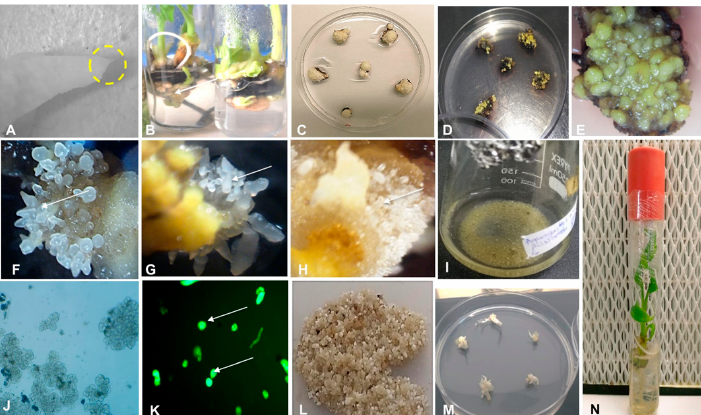
Figure 5. Establishment of embryogenic cell suspension and regeneration of complete plantlet of plantain cultivars Agbagba, Obino l’Ewai, and Orishele. (A) Apical meristem (yellow circle showing the portion of shoot tip having apical meristem under 10X magnification); (B) Axillary buds (arrow indicating axillary buds); (C) Scalps with tiny multiple meristems; (D) Callus induced on the scalp; (E) Yellowish non-embryogenic callus; (F — H) Friable embryogenic callus of Orishele, Obino l’Ewai and Agbagba, respectively (arrows showing the embryos under 10X magnification); (I) Embryogenic cell suspension; (J) Magnified view of cell suspension (40X magnification); (K) Fluorescein diacetate stained viable embryogenic cells (1000X magnification); (L) Mature embryos; (M) Germinating embryos; (N) Complete plantlet .